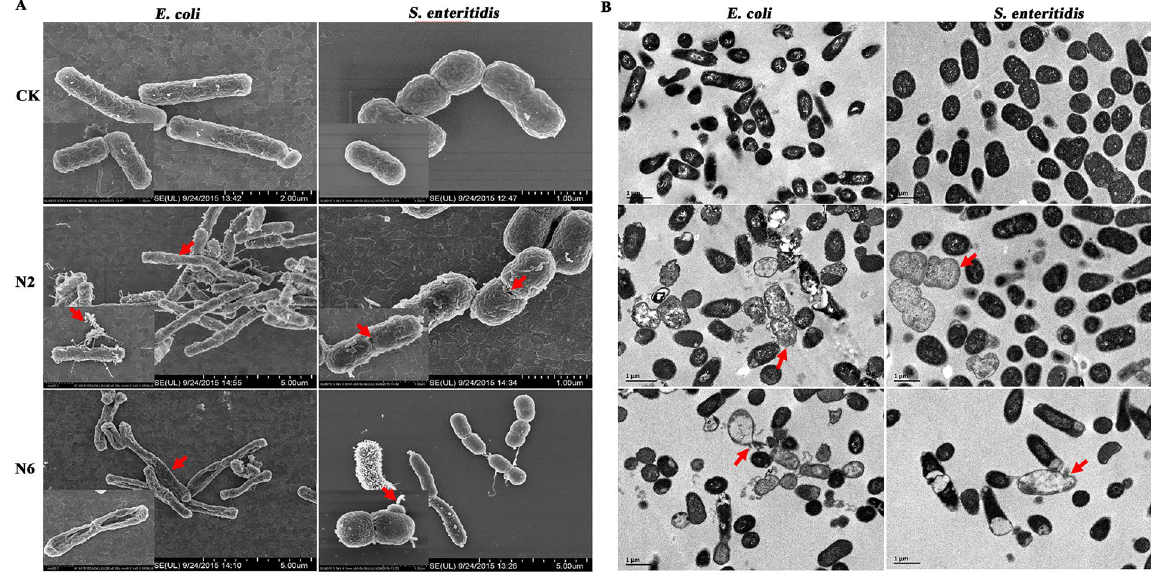
Figure 4. Electron microscopy analysis of E . coli CVCC195 and S . enteritidis CVCC3377 cells treated with N2 and N6. Bacteria in mid-logarithmic growth phases were treated with peptides at 4 × MIC for 2 h. ( A ) SEM images of E . coli CVCC195 and S . enteritidis CVCC3377 cells treated with N2 and N6. ( B ) TEM images of E . coli CVCC195 and S . enteritidis CVCC3377 cells treated with N2 and